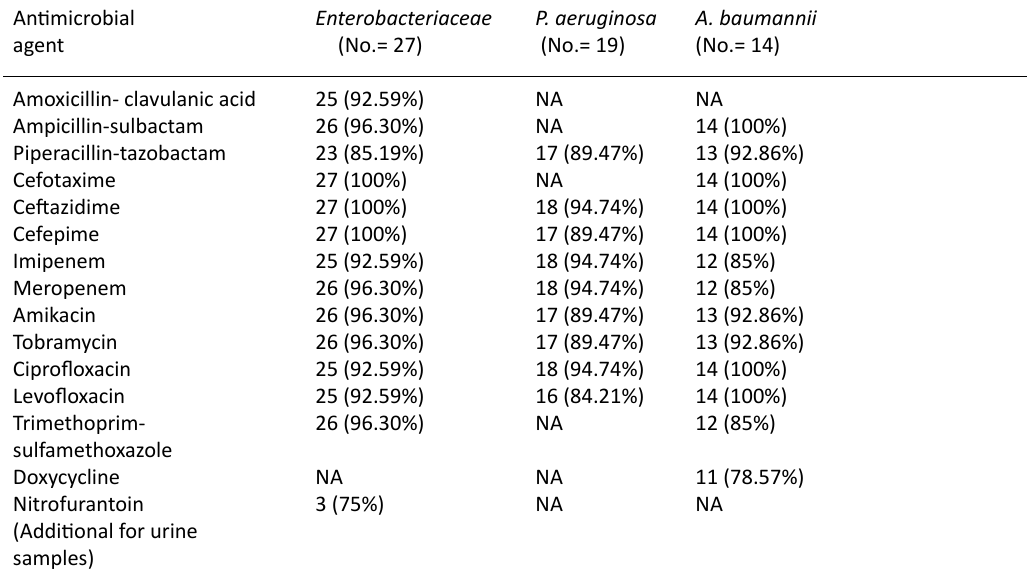
Table 2. Resistance pattern of the MDR bacterial isolates to different antimicrobials Antimicrobial